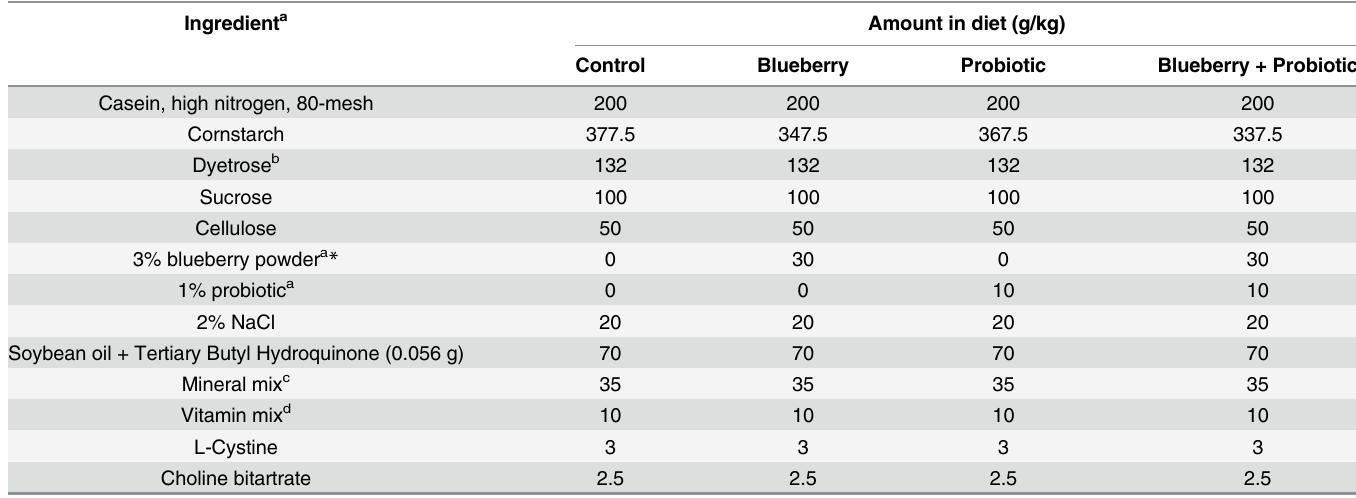
Table 1. Composition of AIN ’ 93G